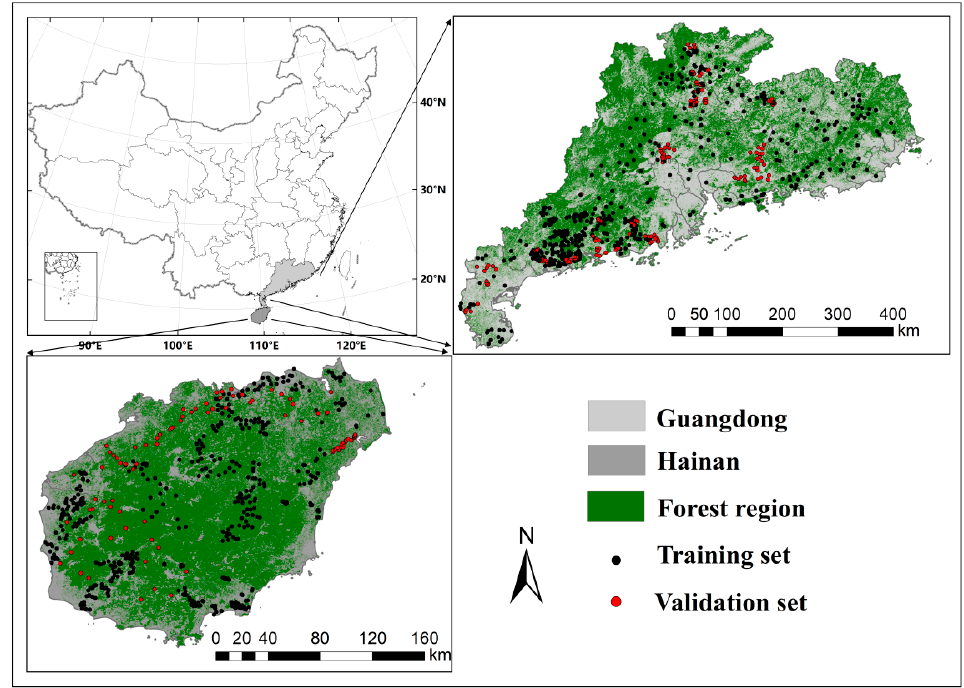
Figure 2. The location of the study region (Guangdong and Hainan Province), and distributions of forests and training and validation plots. forests and training and validation